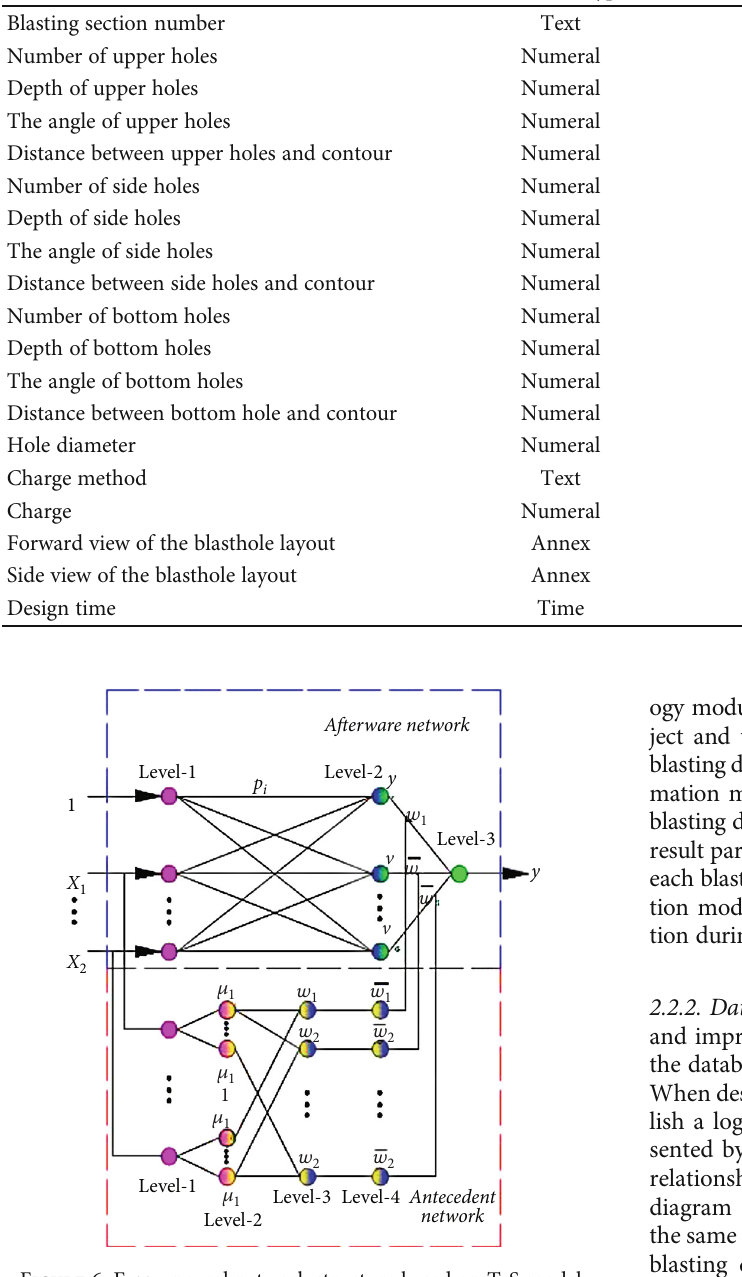
Figure 6: Fuzzy neural network structure based on T-S